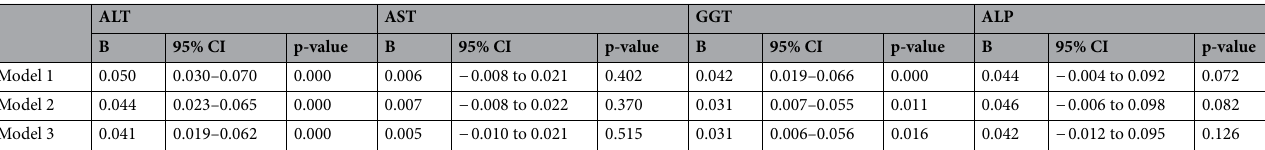
Table 4. Multiple linear regressions to assess the relationship between SUA and liver enzymes. Multiple linear regression analysis was done to assess the relationship between SUA and liver enzymes. Dependent variable is liver enzymes (U/L) and the independent variable is SUA (µmol/L). Model 1: adjusted for age (years). Model 2: model 1 + BMI and FBG. Model 3: model 2 + SBP, DBP and lipid profile